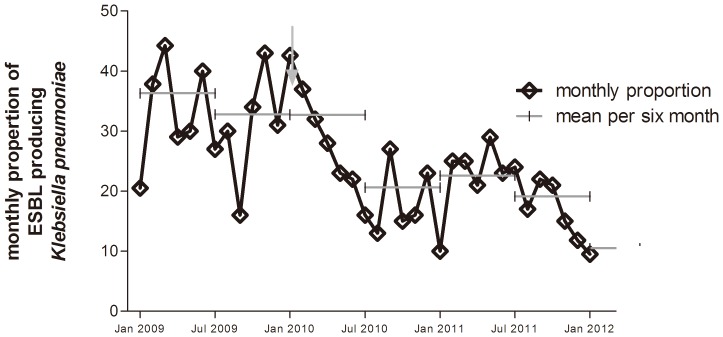
The monthly proportions of ESBL/AmpC-producing isolates of K. pneumoniae in patient clinical samples at Bispebjerg Hospital.The average proportion per six months is shown as grey lines. The arrow indicates the start of the intervention.